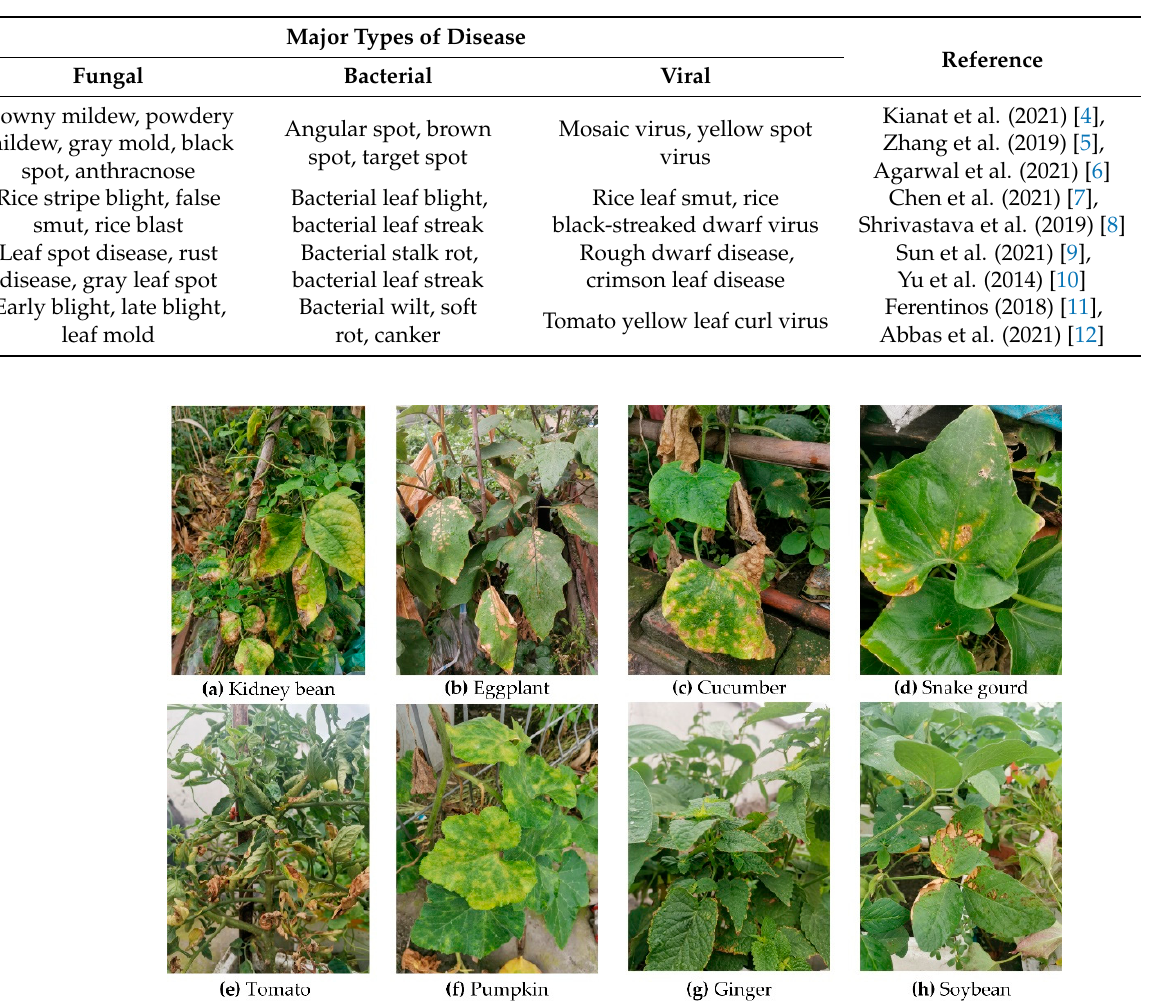
Figure 1. Leaf spot in eight common plants. We took these pictures in the greenhouse of Chengdu Academy of Agriculture and Forestry Sciences.